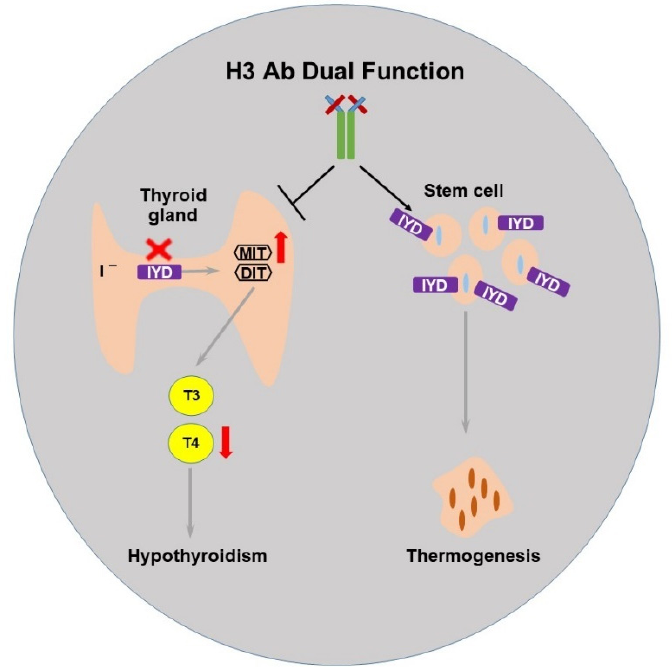
Figure 4. Proposed scheme for the dual function of IYD by H3 Ab. IYD scavenges iodine and, in the presence of the MIT/DIT substrate, catalyzes the production of triiodothyronine (T3) and thyroxine (T4) thyroid hormones. H3 Ab can block the IYD enzyme, which leads to increased MIT substrate, less iodine scavenged, and decreased T4 levels. IYD-expressing stem cells function as a receptor for H3 Ab, and binding of H3 Ab to IYD induces differentiation of the stem cells into brown adipocytes with increased lipid droplets.